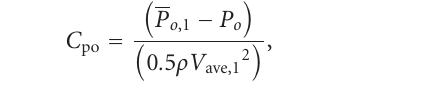
Figure 5 plots distributions of total pressure loss coe ffi - cients ( C po ) at 0.1 axial chord lengths downstream of the trailing edge. Three major high-loss regions can be identified. Firstly, regions close to the casing wall are dominated by the tip clearance vortex. Secondly, a high-loss area caused by surface and to the mid-span. The third high-loss region is caused by the blade wake. Losses are much larger in the tip clearance vortex region than in the other two